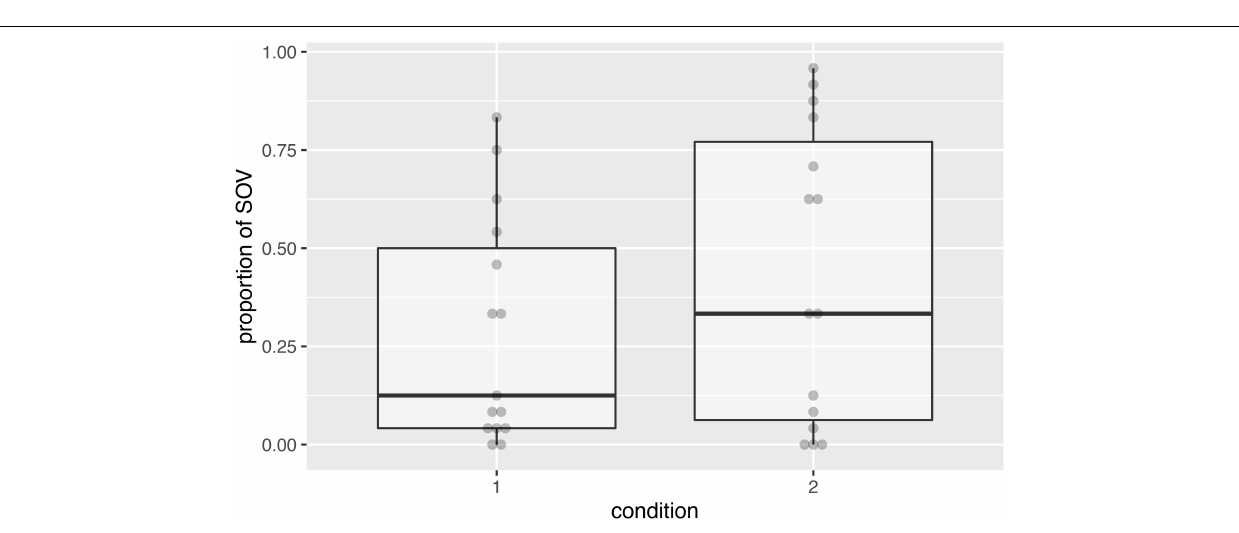
FIGURE 4 | Graph showing the proportion of SOV responses to both types of non-reversible events by condition. Gray dots represent means per participant. In condition 1 (reversible events first), the median level of SOV was lower than that in condition 2 (reversible events last) as predicted by the hypothesis that word-order consistency is a strategy to deal with potential ambiguity. However, the difference between the conditions was not